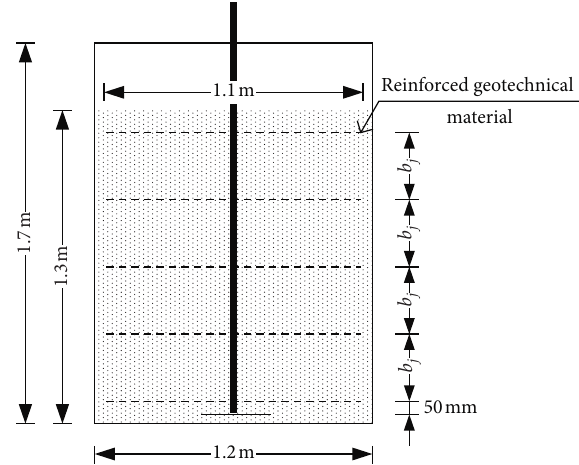
Figure 5: Reinforcement layout. Table 1: Fundamental characteristics of reinforced geotechnical materials.